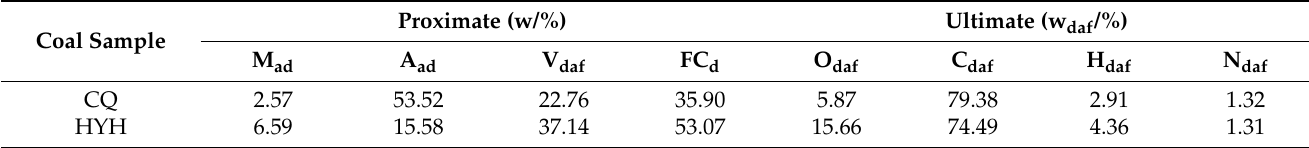
Table 1. Results of proximate and ultimate analyses on coal samples.